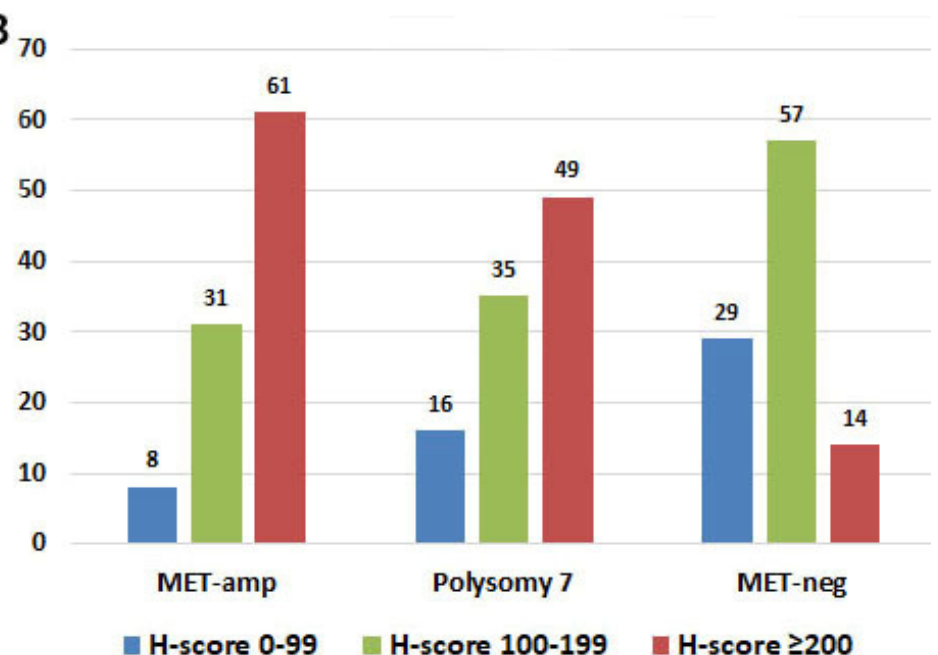
Figure 3. Correlation of FISH groups and immunohistochemistry results. ( A ): Proportion of patients with different level of MET expression (IHC0+~3+) in patients with MET-amp, Polysomy 7 and MET-neg. ( B ): Proportion of patients with MET H-score of 0–99, 100–199 and ≥ 200 in patients with MET amp, Polysomy 7 and MET neg. Presented as percentage of